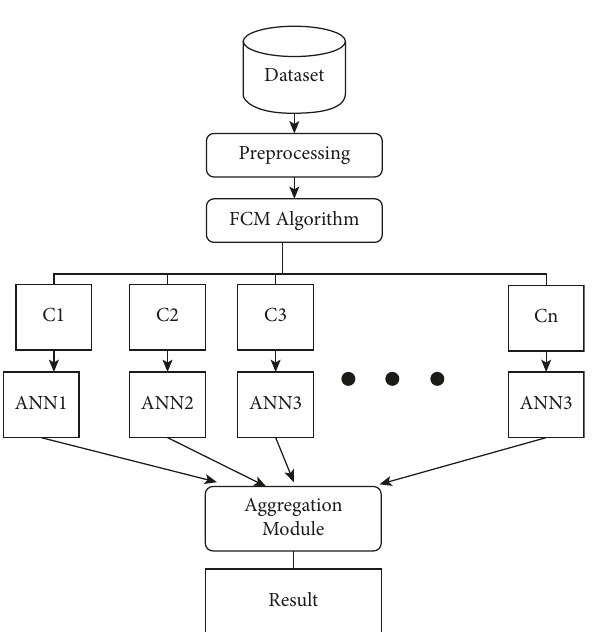
Figure 3: Flowchart of FCM-ANN